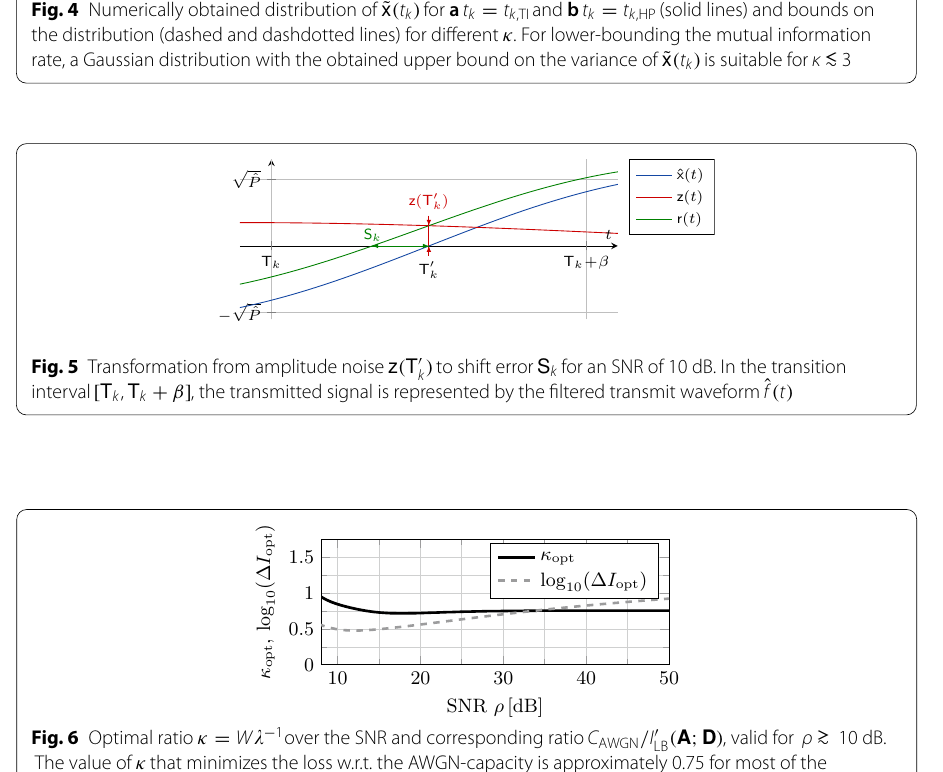
Fig. 6 Optimal ratio κ = W (cid:31) − 1 over the SNR and corresponding ratio C AWGN / I ′ LB ( A ; D ) , valid for ρ ≳ 10 dB. The value of κ that minimizes the loss w.r.t. the AWGN-capacity is approximately 0.75 for most of the mid-to-high SNR